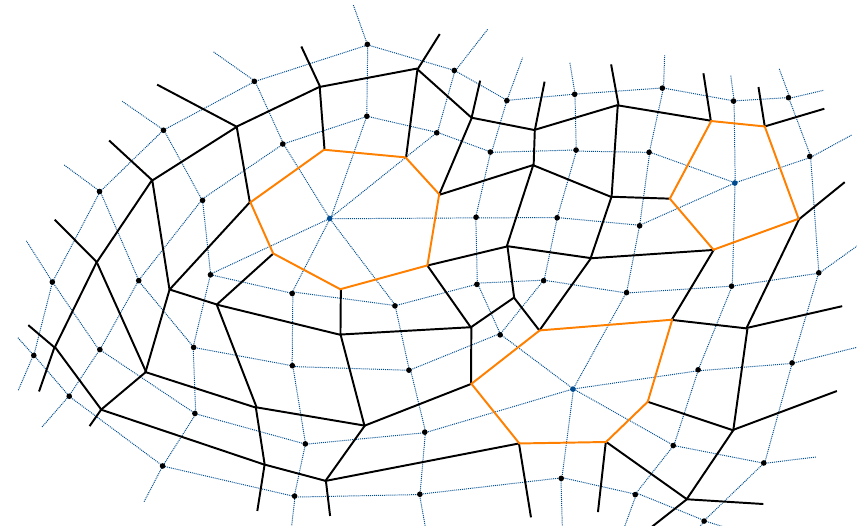
Figure 5: Discretized worldsheet for a quartic matrix integral with deformations, showing the quartic ribbon graph (blue) and the dual graph (black) which contains polygonic holes (orange) due to the deformations. The quartic interactions (black dots) are weighted by τ (as defined in B), the extra vertices (blue dots) from the 4 deformations are weighed by traces of H 0